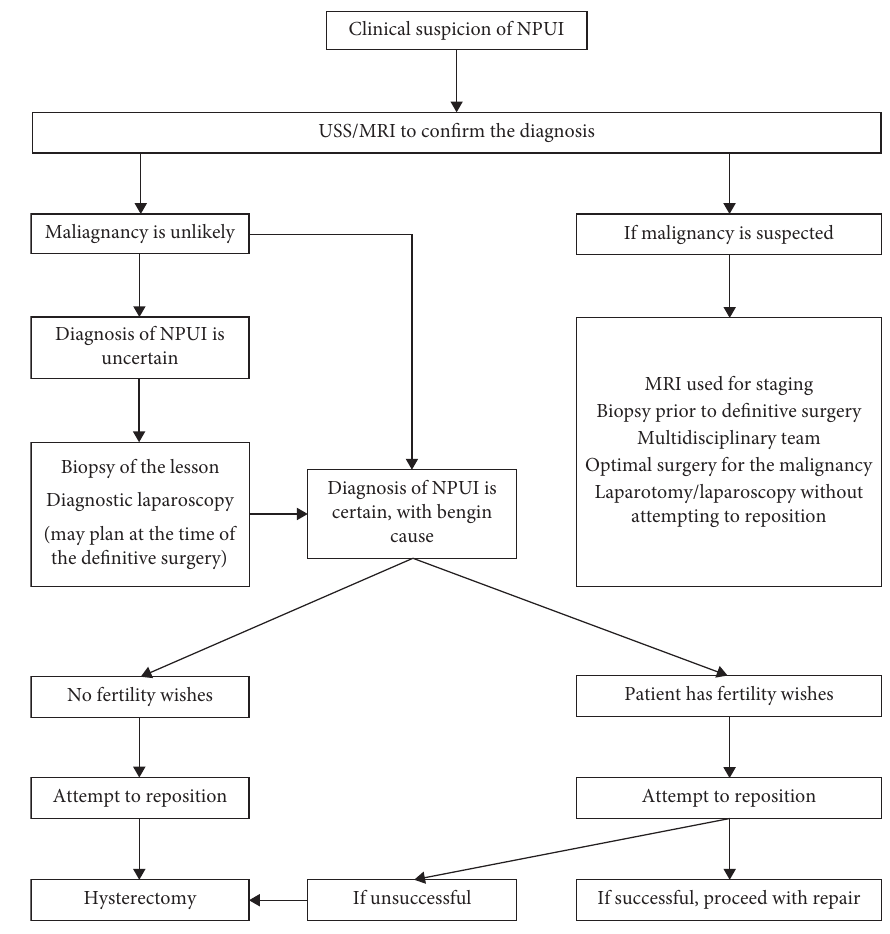
Figure 4: Treatment algorithm of nonpuerperal uterine Table 3: Surgical options used in the treatment of NPUI.